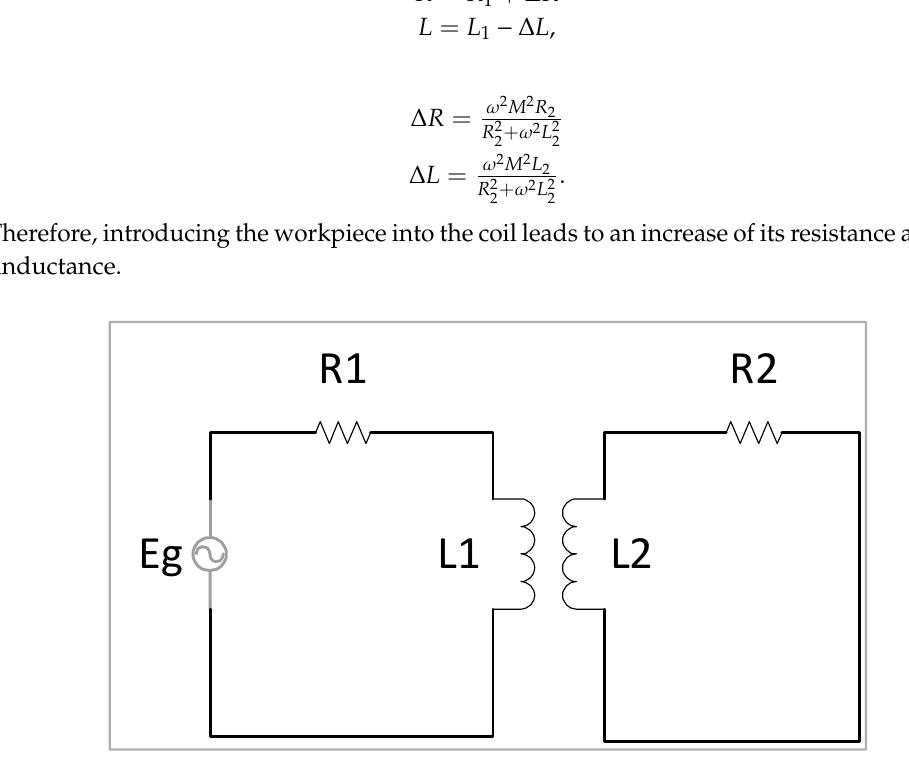
Figure 11. Cooling power—coil (copper).